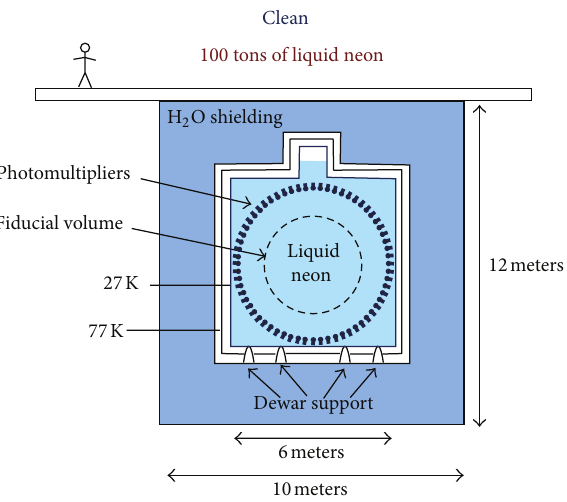
Figure 19: Scheme of the CLEAN detector. Taken from